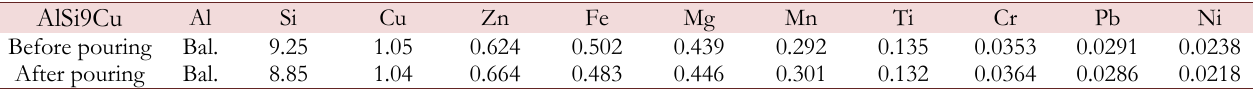
Table 1: Chemical composition (wt%) of the aluminum alloy before and after